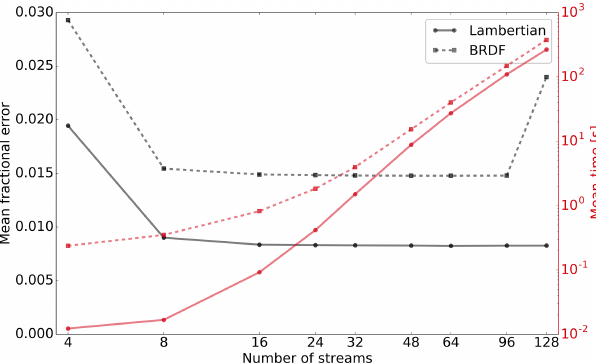
Figure 2. Accuracy (in black) and computing times (in red) for the DISORT model as a function of the number of streams used. The Lambertian and oceanic BRDF surface cases are shown with solid and dashed lines, respectively. The accuracy is shown in terms of mean fractional error against VLIDORT (vector). The computing times are an average for 20 geometries and were estimated on a processor AMD Opteron 6378, 2.4GHz. Please note the logarithmic scales for the number of streams used in the DISORT calculations ( x axis) and the timings (right vertical